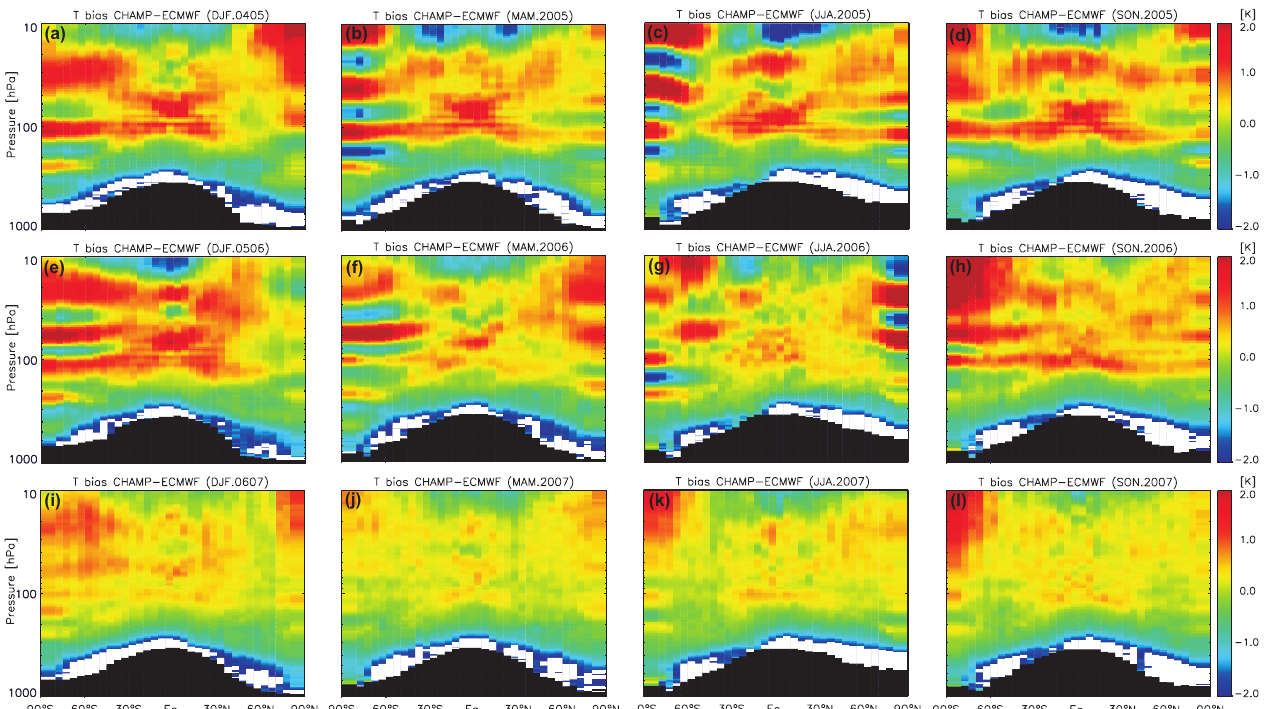
Fig. 7. Zonal mean temperature bias between CHAMP and ECMWF for the pressure (altitude) range 1000–10 hPa for different seasons (DJF.0405–SON2007). The meridional resolution is 5 ◦ between 77.5 ◦ N–77.5 ◦ S and 10 ◦ for 85 ◦ N and 85 ◦ S. The vertical pressure resolu- tion corresponds to an altitude resolution of about 200–300m. The black areas denote regions with temperatures above 250K. In the white areas the bias is less than −